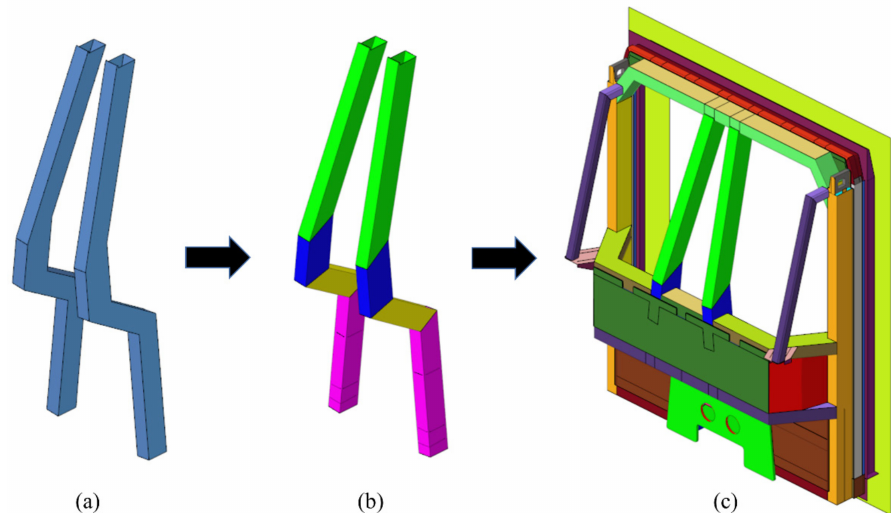
Figure 11. Finite element model for VSCP: ( a ) USCP; ( b ) VSCP; ( c ) cab car front-end with VSCP.